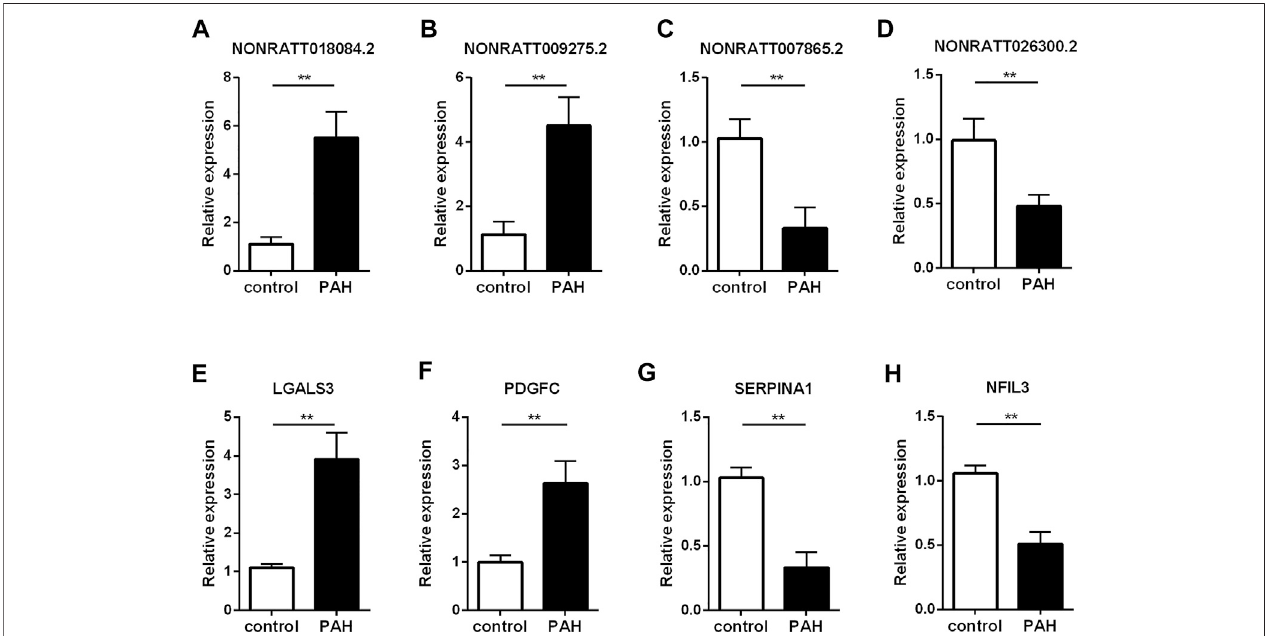
FIGURE 4 | Veri fi cation of the critical dysregulated lncRNAs and mRNAs by qRT-PCR. (A – D) The expression levels of four lncRNAs (NONRATT018084.2, NONRATT009275.2, NONRATT007865.2 and NONRATT026300.2). (E – H) The expression levels of four mRNAs (LGALS3, PDGFC, SERPINA1, and NFIL3). GAPDH was used as the internal control. The data are expressed as the mean ± SD ( n (cid:1) 3). ** p < 0.01 vs. the control group.